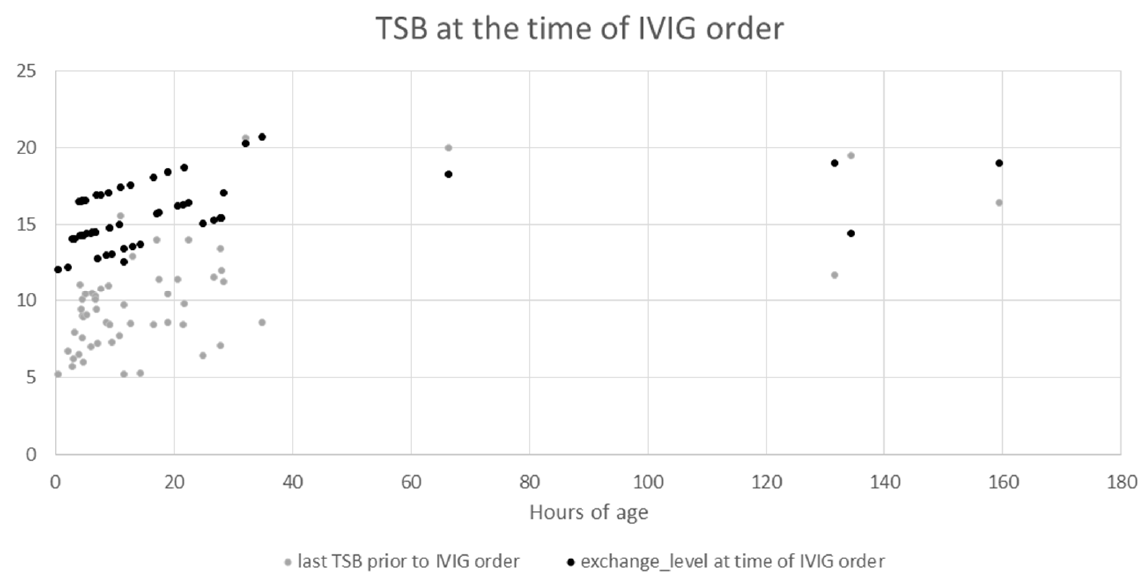
Figure 1. TSB at the time of IVIG order. The y-axis denotes the serum bilirubin in mg/dL with the grey dots indicating the last serum bilirubin prior to IVIG being ordered and the black dots indicating the exchange level at the same time. The x-axis denotes the hour of age the level was obtained.